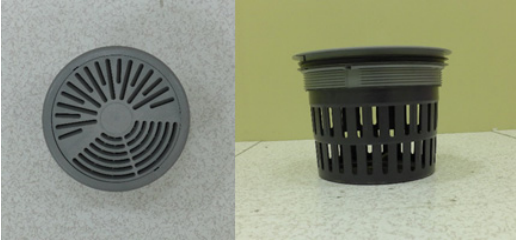
Figure 9. Air supply diffuser (rotary floor twist outlet type).